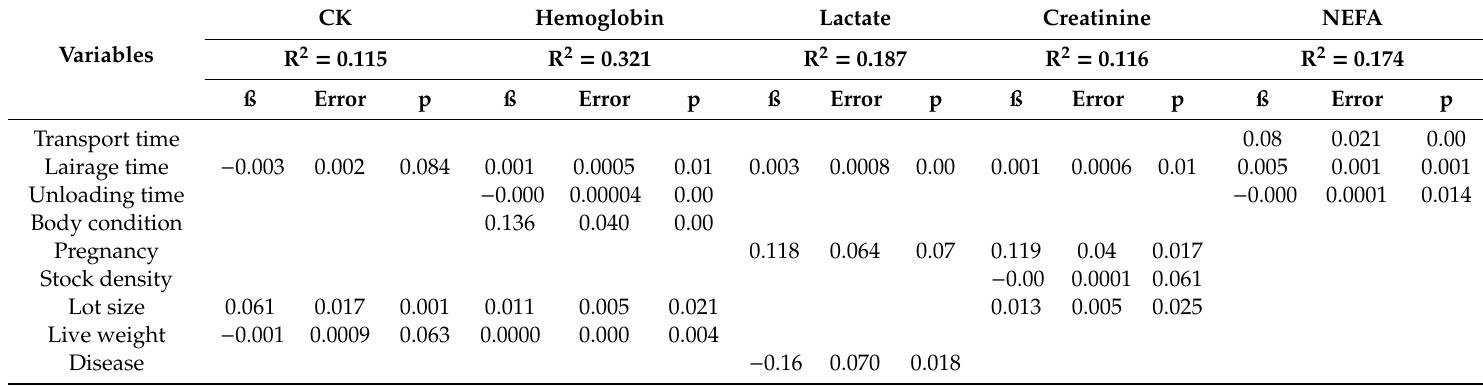
Table 6. Results from multiple linear regression models of the relationship between transformed blood values of creatine kinase (CK), hemoglobin, lactate, creatinine, and non-esterified fatty acid (NEFA) with the independent variables: Y = β 0 + β 1 Z i + ε i , where Y is interactions (per min), β 0 (intercept), β 1 (slope), Z i (predictive variable), and ε i